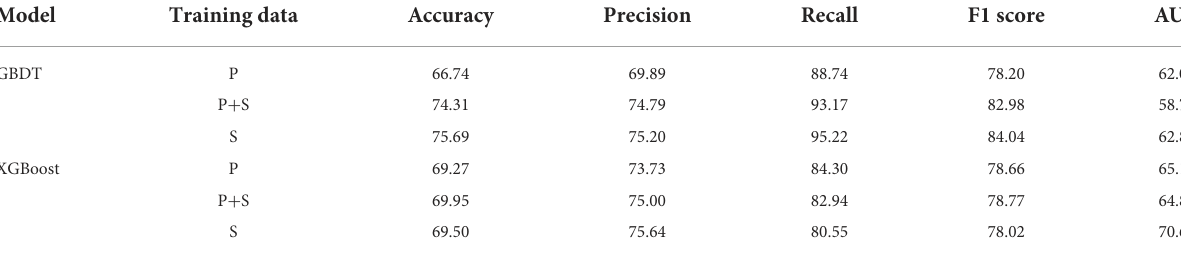
TABLE 8 The performance of the MCI classification models (units: